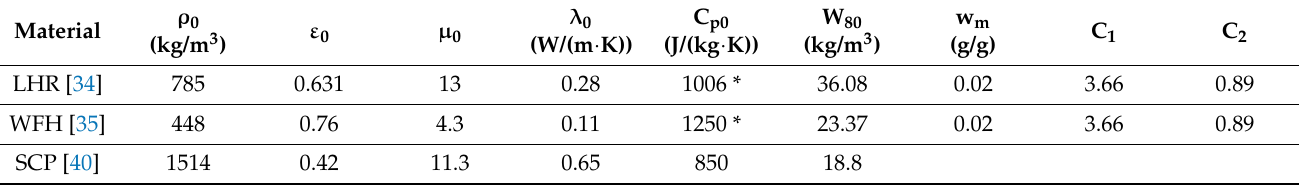
Table 3. Physical properties at dry state of materials.